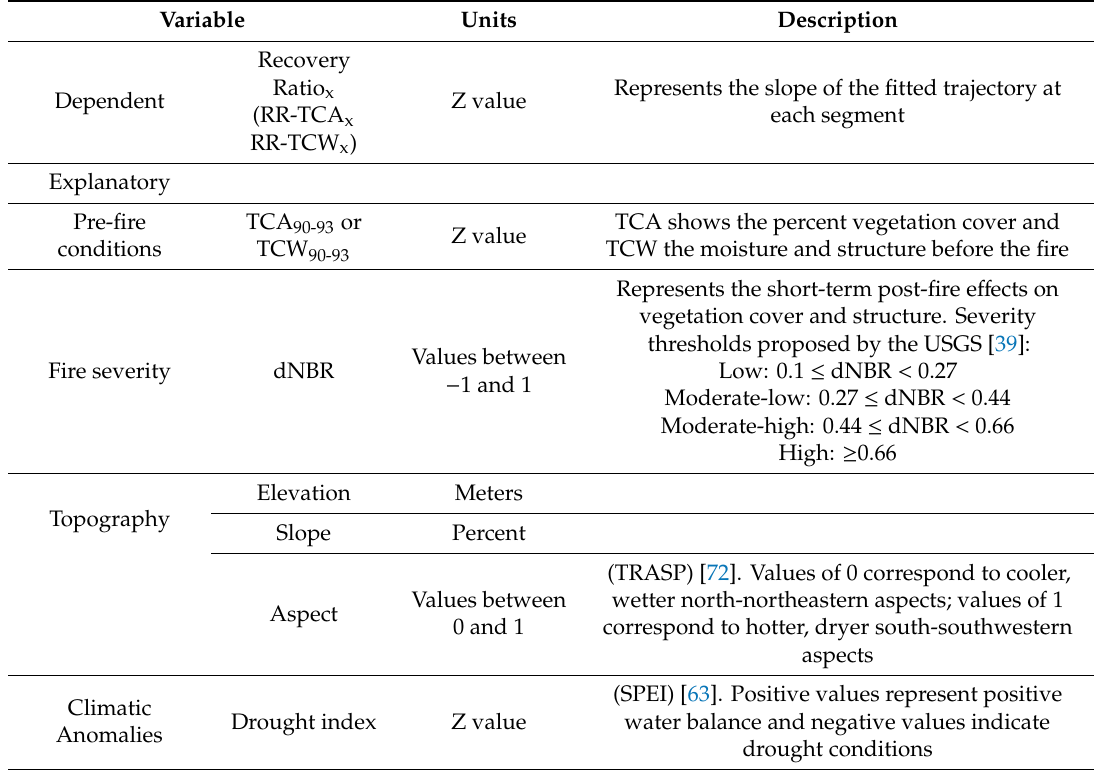
Table 1. List of variables used in the regression